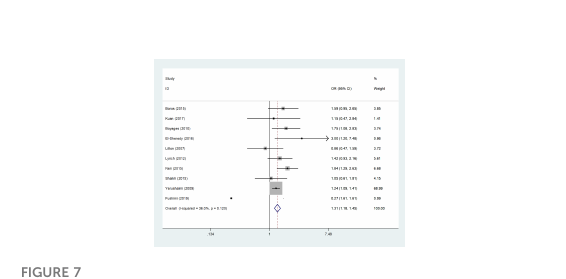
FIGURE 7 Forest plot of the mortality rates of MMBC versus UFBC